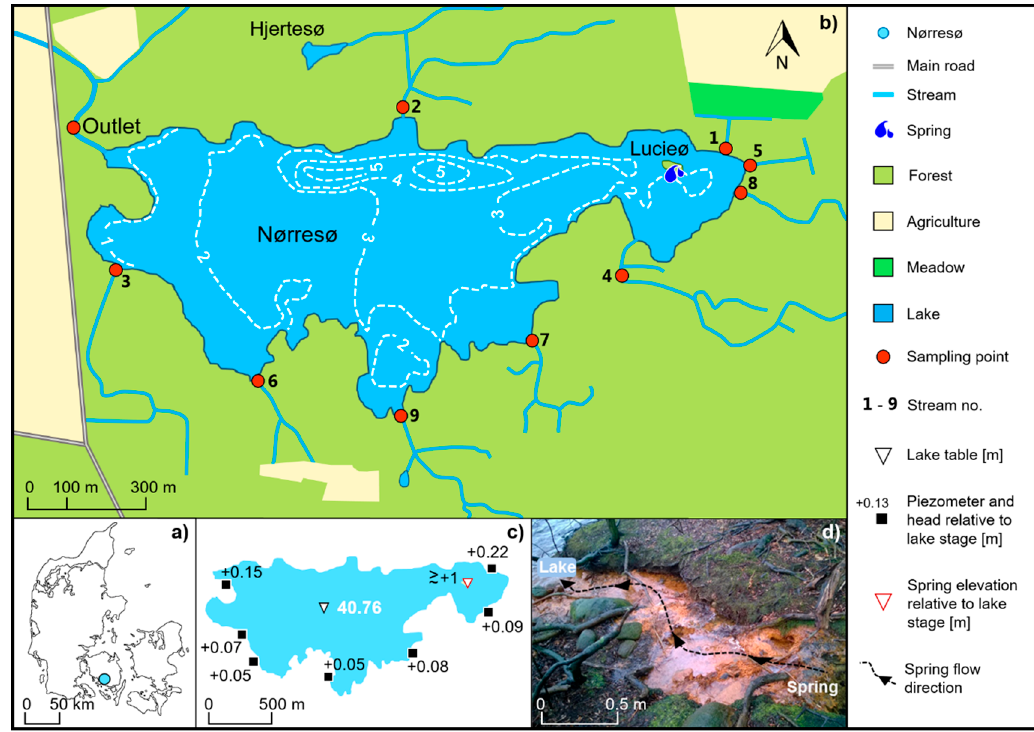
Figure 1. ( a ) Location of the Lake Nørresø in the southern part of Fyn, Denmark. ( b ) Overview of the numbering of streams, and the locations of stream sampling points and the outlet. The locations of the small island, Lucieø, hosting a spring and the small lake, Hjertesø, are also indicated. The dashed white lines indicate lake bathymetry (in meters; [29]). ( c ) The relative hydraulic head in seven piezometric wells placed at ~3 m depth. ( d ) Photo of the spring on the island Lucieø (black arrows indicate flow direction). Iron-oxides stain the bed of the 4-m-long stream which connects the spring to the lake. Lake stratification has not been observed in Nørresø [27,29], most likely due to the shallow depth be a well-mixed